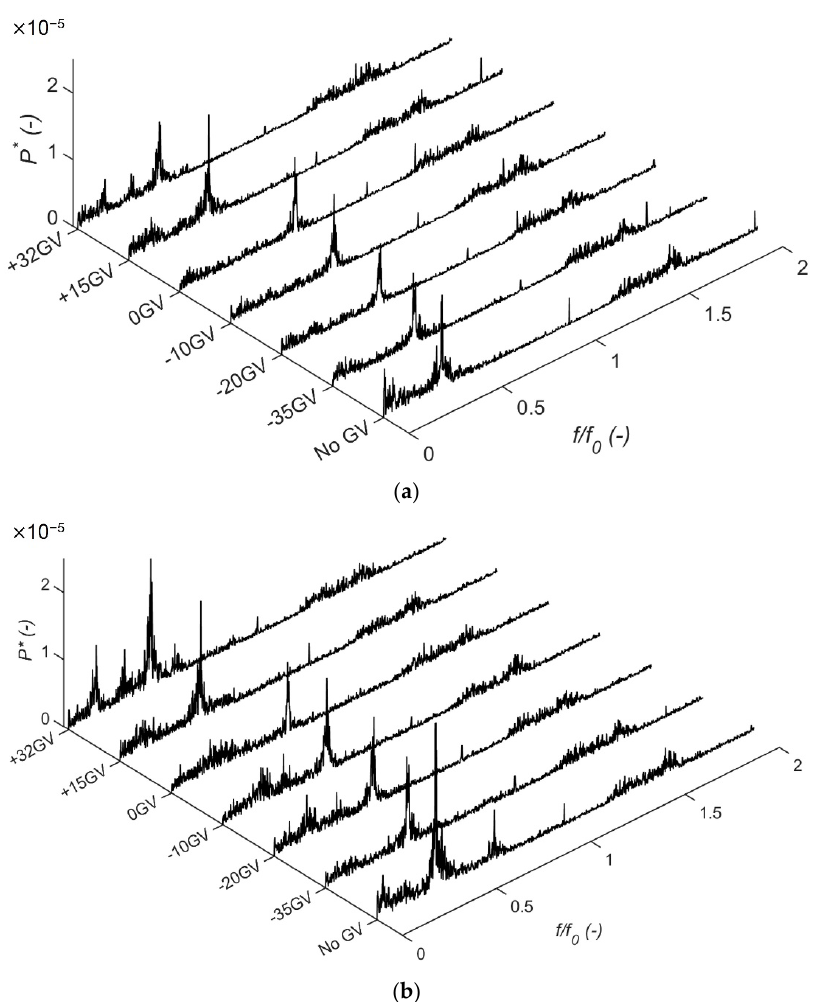
Figure 8. Normalized pressure signal FFTs for PL2 operating conditions without and with the GV system at ( a ) DT1 sensor at L1 and ( b ) DT4 sensor at L2.